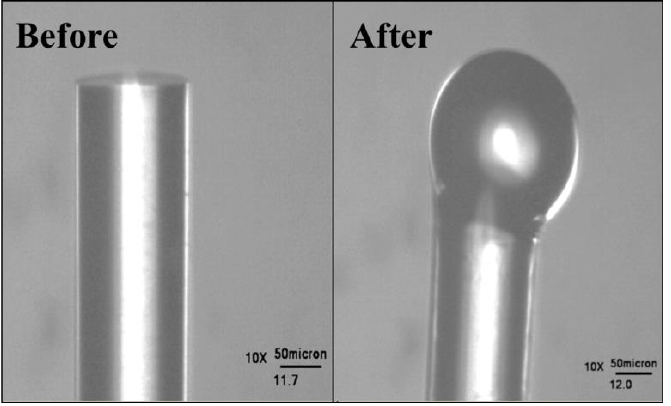
Figure 2. Microscopic images of the tip of a single mode optical fiber before and after gravimetric melting with a CO 2